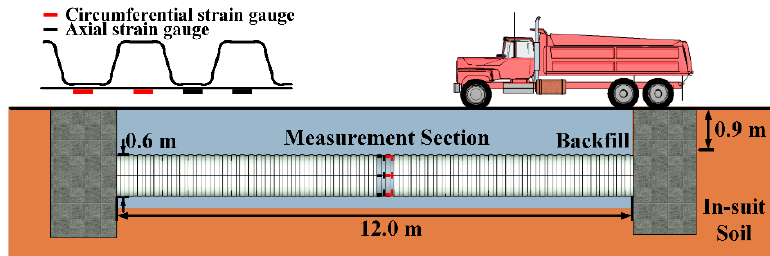
Figure 24. Installation of high-density polyethylene (HDPE) pipe and strain gauge arrangement.